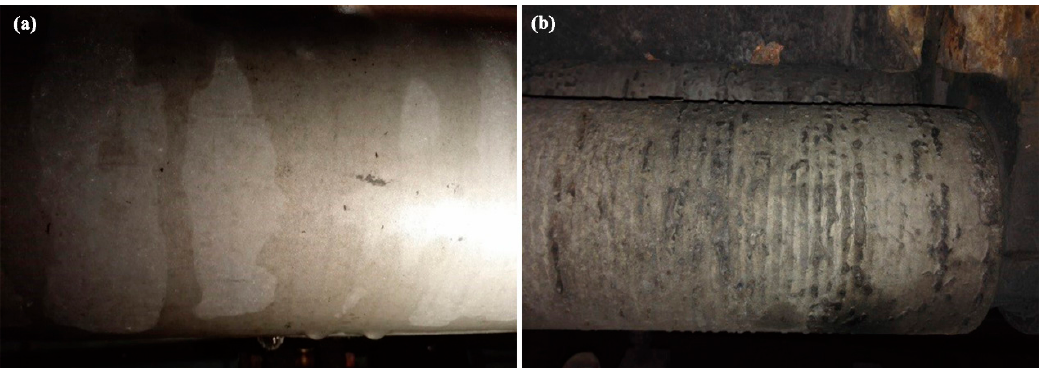
Figure 15. The surface comparison of two kinds of foot roller after three work periods: ( a ) repaired by laser cladding; ( b ) repaired by resurfacing welding.